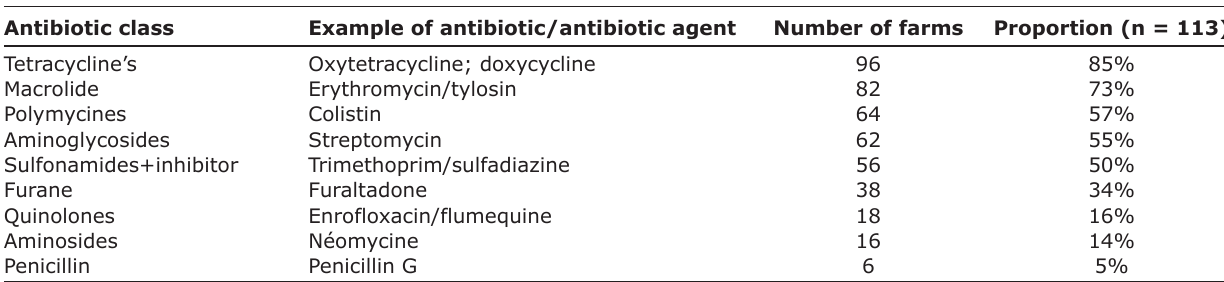
Table-3: Antibiotics used in poultry and pig farms in South Togo. A – Antibiotics used in poultry farms (n is the total number of farms from which veterinary drugs, including antibiotics, were recorded)